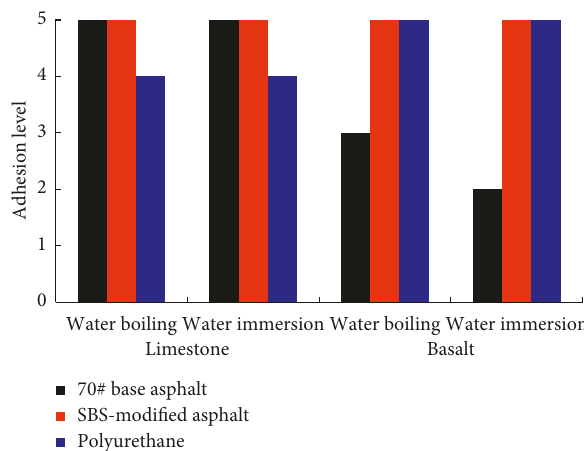
Figure 15: Adhesion level of different aggregates and